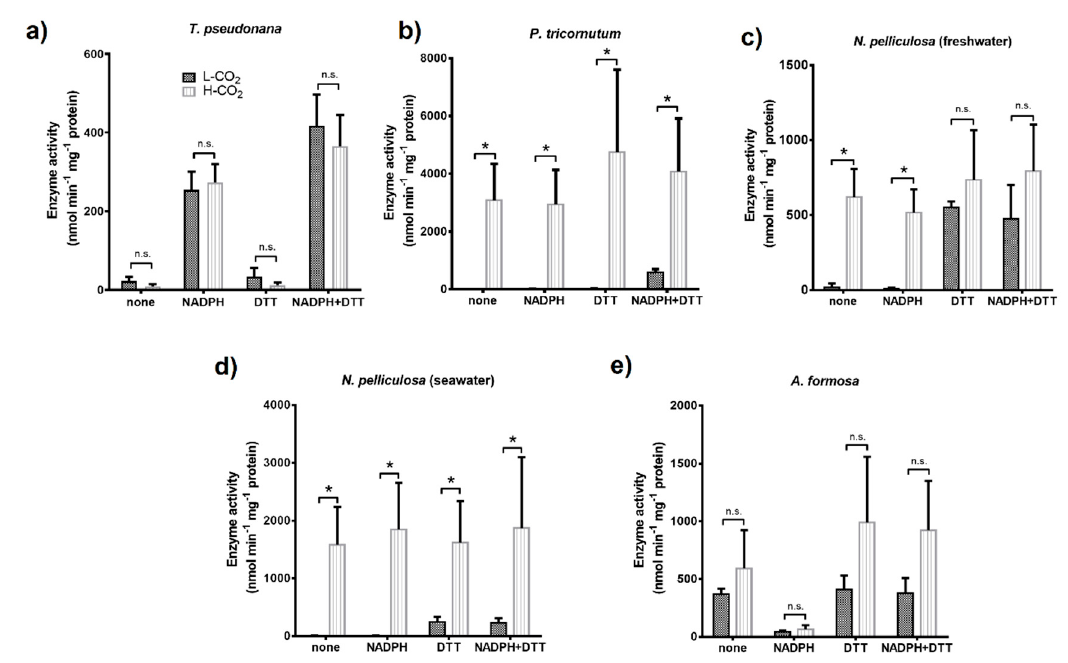
Figure 4. NADPH-dependent activity of chloroplast glyceraldehyde 3-phosphate dehydrogenase (GAPDH) in diatoms ( a – e ). All panels show activity measurements of diatom crude extracts from cultures grown at low CO 2 (L-CO 2 ; 400 ppm, dark grey bars) or high CO 2 (H-CO 2 ; 20,000 ppm, light grey and dashed bars), as specified in panel ( a ), and without any treatment (none) or treated with either 0.2 mM NADPH or 5 mM DTT, or both prior to assay. Average and error bars (SD) are represented (n = 3). * p ≤ 0.05 and ns, not significant.